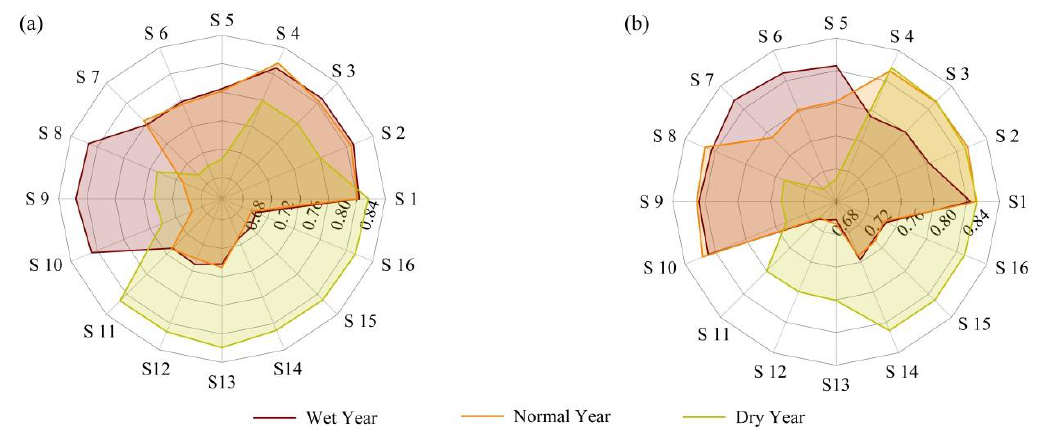
Figure 9. Absolute correlation degree. ( a ) corn, ( b ) soybean.